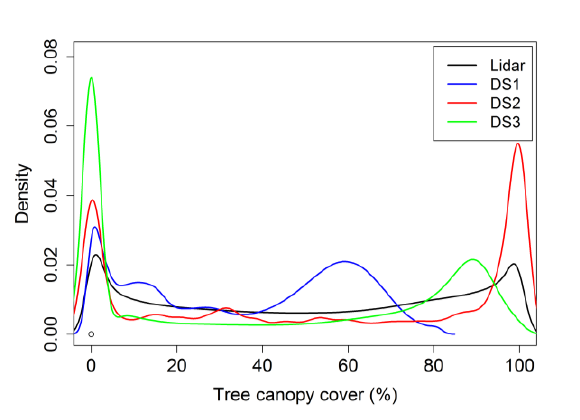
Figure 3. Frequency distributions of percent tree canopy cover in the study area from Lidar reference and three Landsat-based